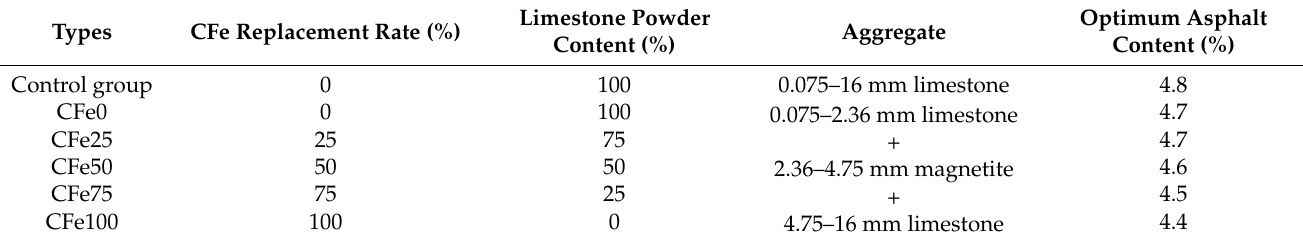
Figure 7. AC-13 gradation of the aggregate. Table 4. Test scheme and optimum asphalt content.